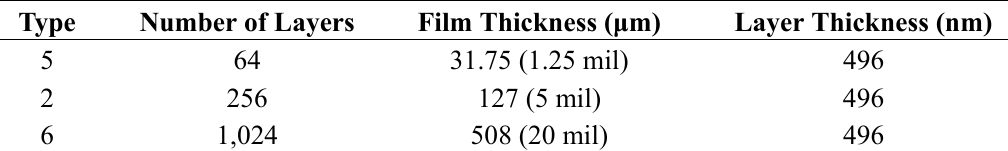
Table 2. Films with various film thicknesses.